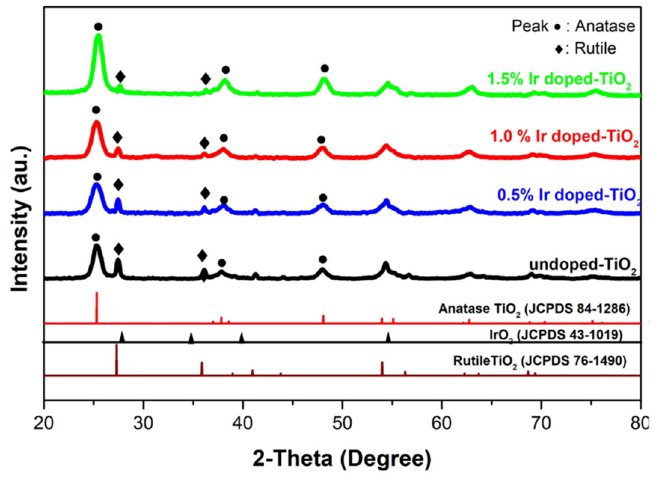
Figure 3. X-ray diffraction patterns of Ir-doped TiO 2 photocatalysts with different Ir-doped ratios of 0.5 mol%, 1.0 mol%, and 1.5 mol% respectively.